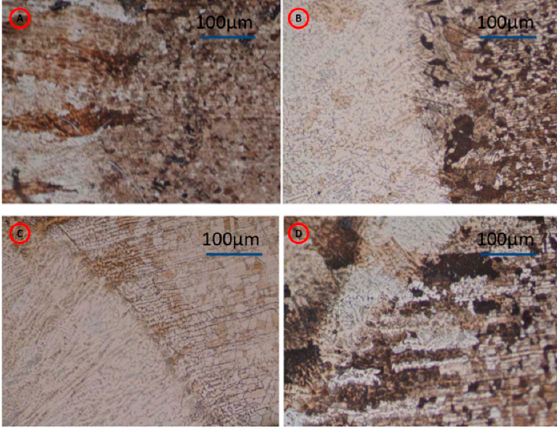
Figure 3. Microstructure of the weld made in an Ar chamber, ×100. Interface WZ ‐ TAZ: ( A ) not irradiated; ( B ) at 200 Gy; ( C ) at 700 Gy; ( D ) at 1000 Gy.